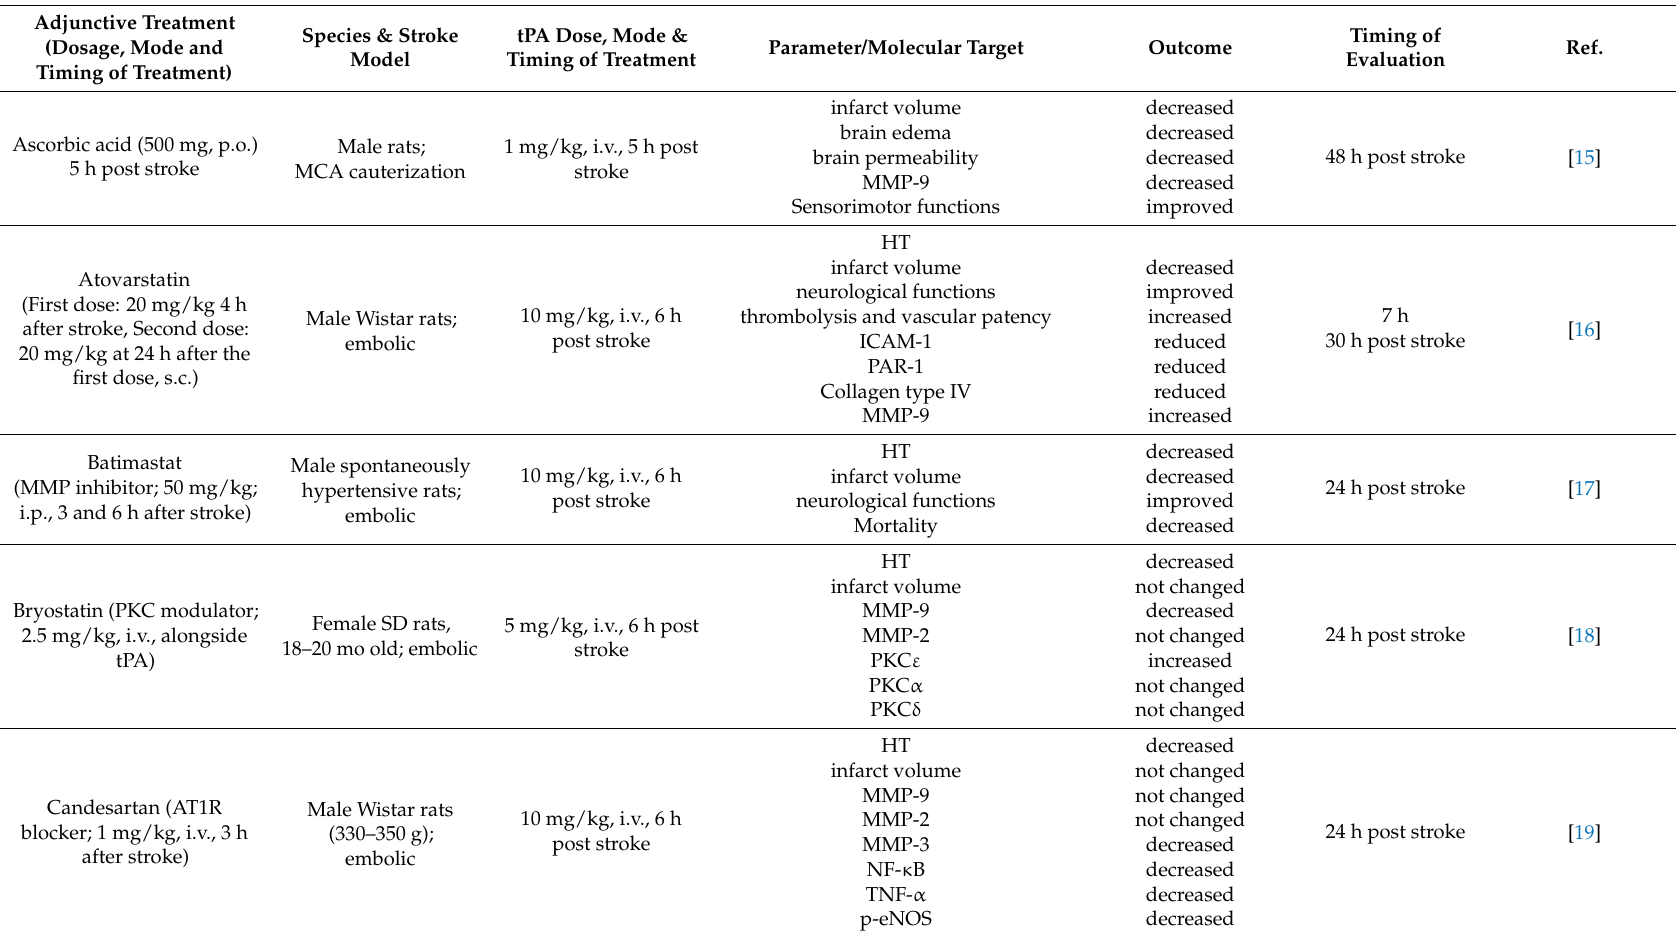
Table 1. Pharmacological adjunctive treatments to extend therapeutic window for ischemic stroke